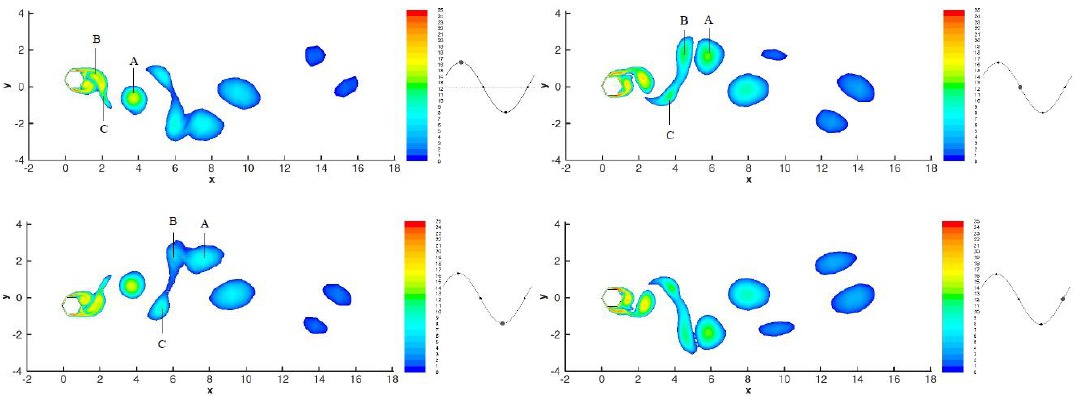
Figure 8. Vorticity contours at four instants in a vibration period of the corner-oriented hexagonal cylinder at V r = 11.41 at 18.18 < t* <